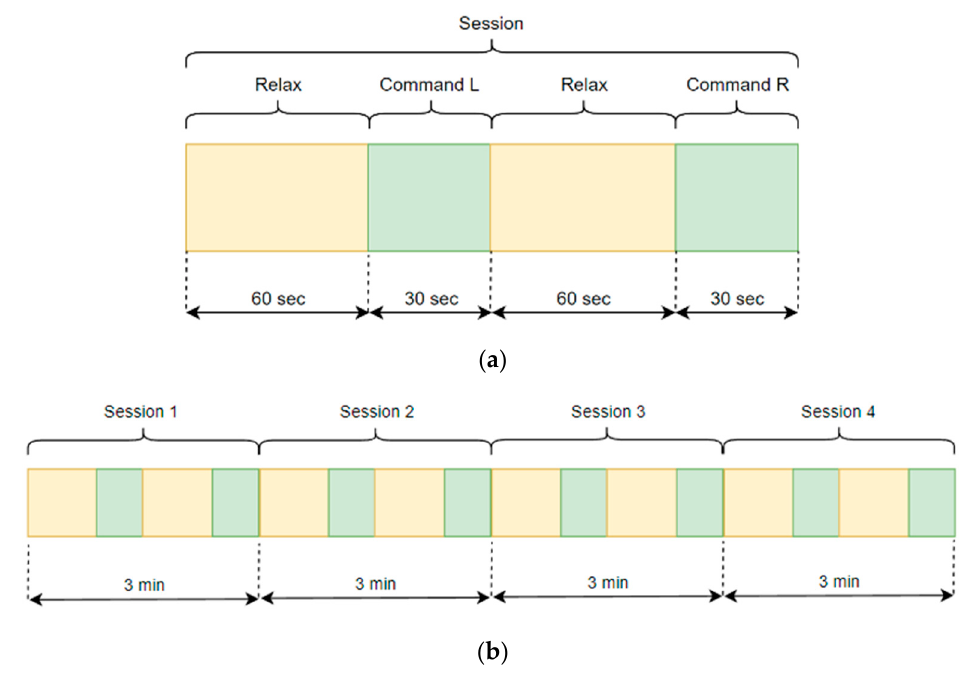
Figure 1. Description of the time process for ( a ) one experiment; ( b ) all sessions.